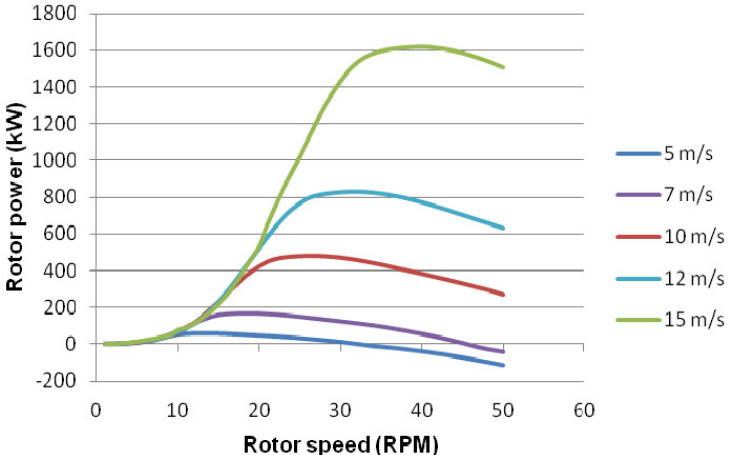
Figure 10. Design of a simple variable speed